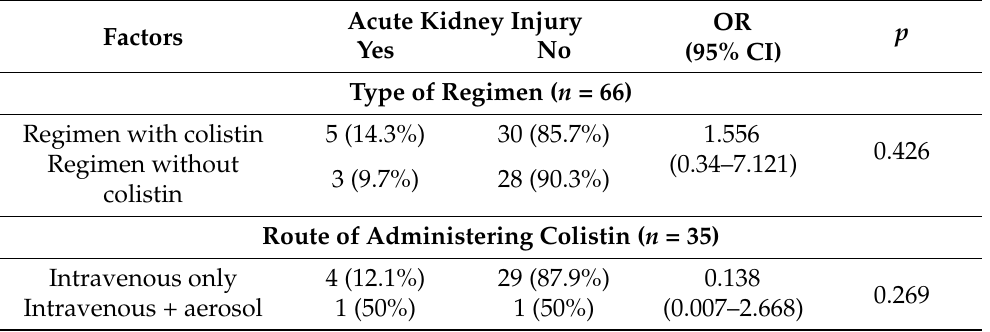
Table 10. Acute kidney injury and related